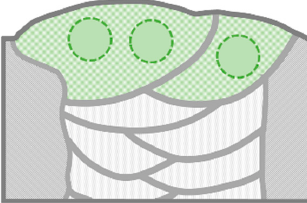
Figure 1. Schematic drawing of the upper part of the cross section of the investigated 2.25Cr-1Mo-0.25V SAW (submerged-arc welding) all-weld metal. The positions in the last two weld beads where the dilatometer-specimens were taken from are highlighted with dashed circles.